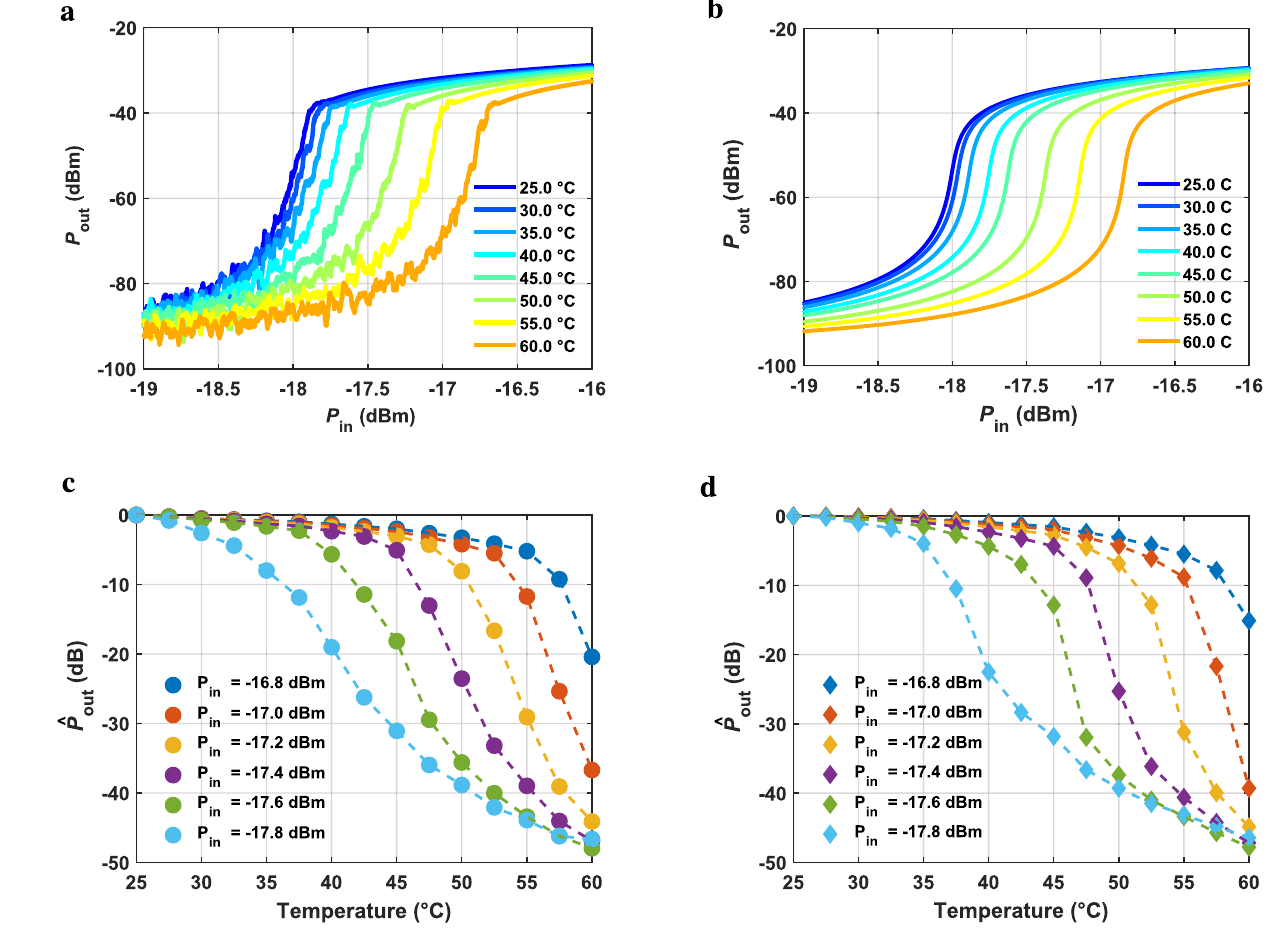
Figure 4. Evaluation of the sensing capabilities of the fabricated SubHT. ( a, b ) Measured ( a ) and simulated ( b ) P out versus P in trends of the fabricated SubHT, at f in = 886 MHz and for different temperatures ( T s) ranging ◦ ◦ from 25 C to 60 C. ( c, d ) Measured ( c ) and simulated ( d ) P out versus T trends of the fabricated SubHT for ◦ different P in values close to the P th value extracted at 25 C. All the reported curves ( a – d ) were extracted through a wired characterization